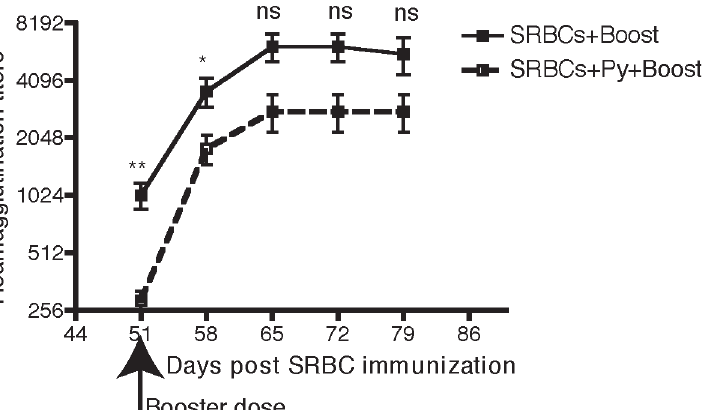
Fig 4. P . yoelli infection does not disrupt the anamnestic response to SRBC immunization. BALB/c mice were immunized with 10% SRBC suspension. Two days later, half of these mice were infected with 10 6 P . yoelii while the other half of mice were injected with saline. A booster dose of 10% SRBC suspension was given after 40+ days to both groups of mice. Serum samples were collected on the indicated days